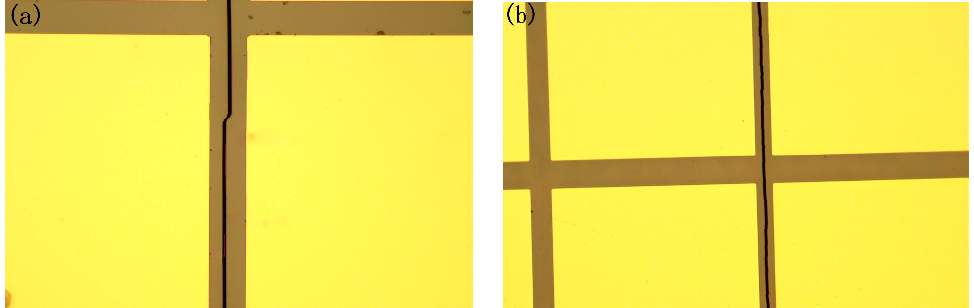
Figure 8. The crack from cutting the 200 μ m SiC using ( a ) a 10 W/1040 nm continuous laser and ( b ) an 8 W/1040 nm continuous laser.